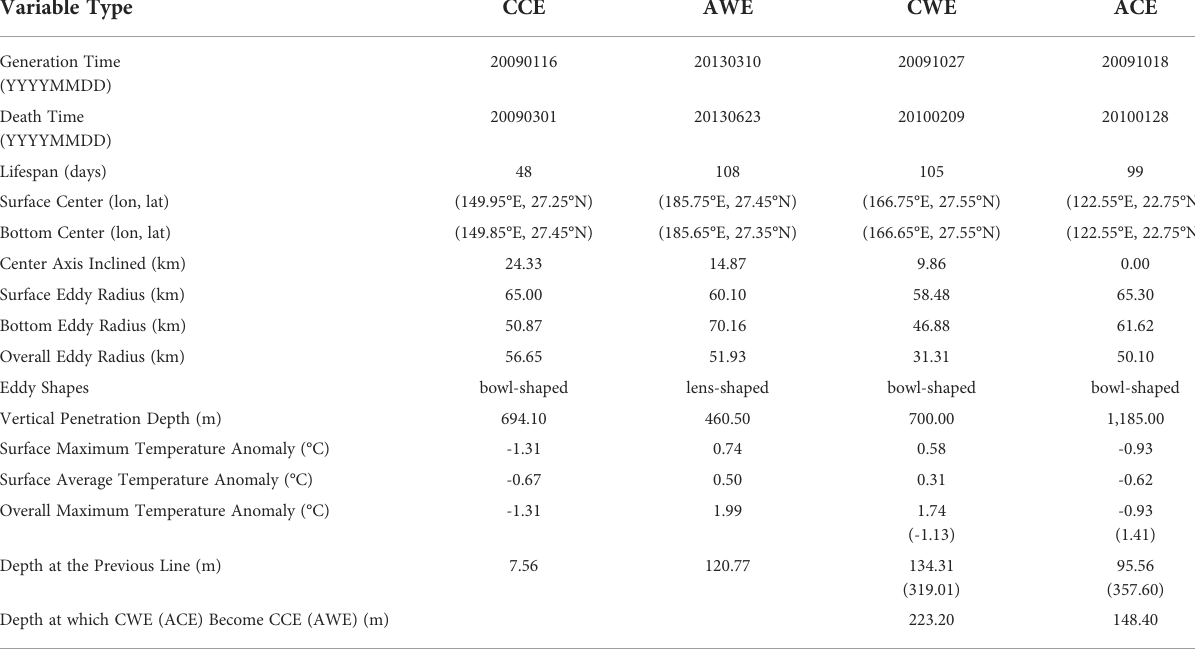
TABLE 1 Basic information of the four types of eddy cases.